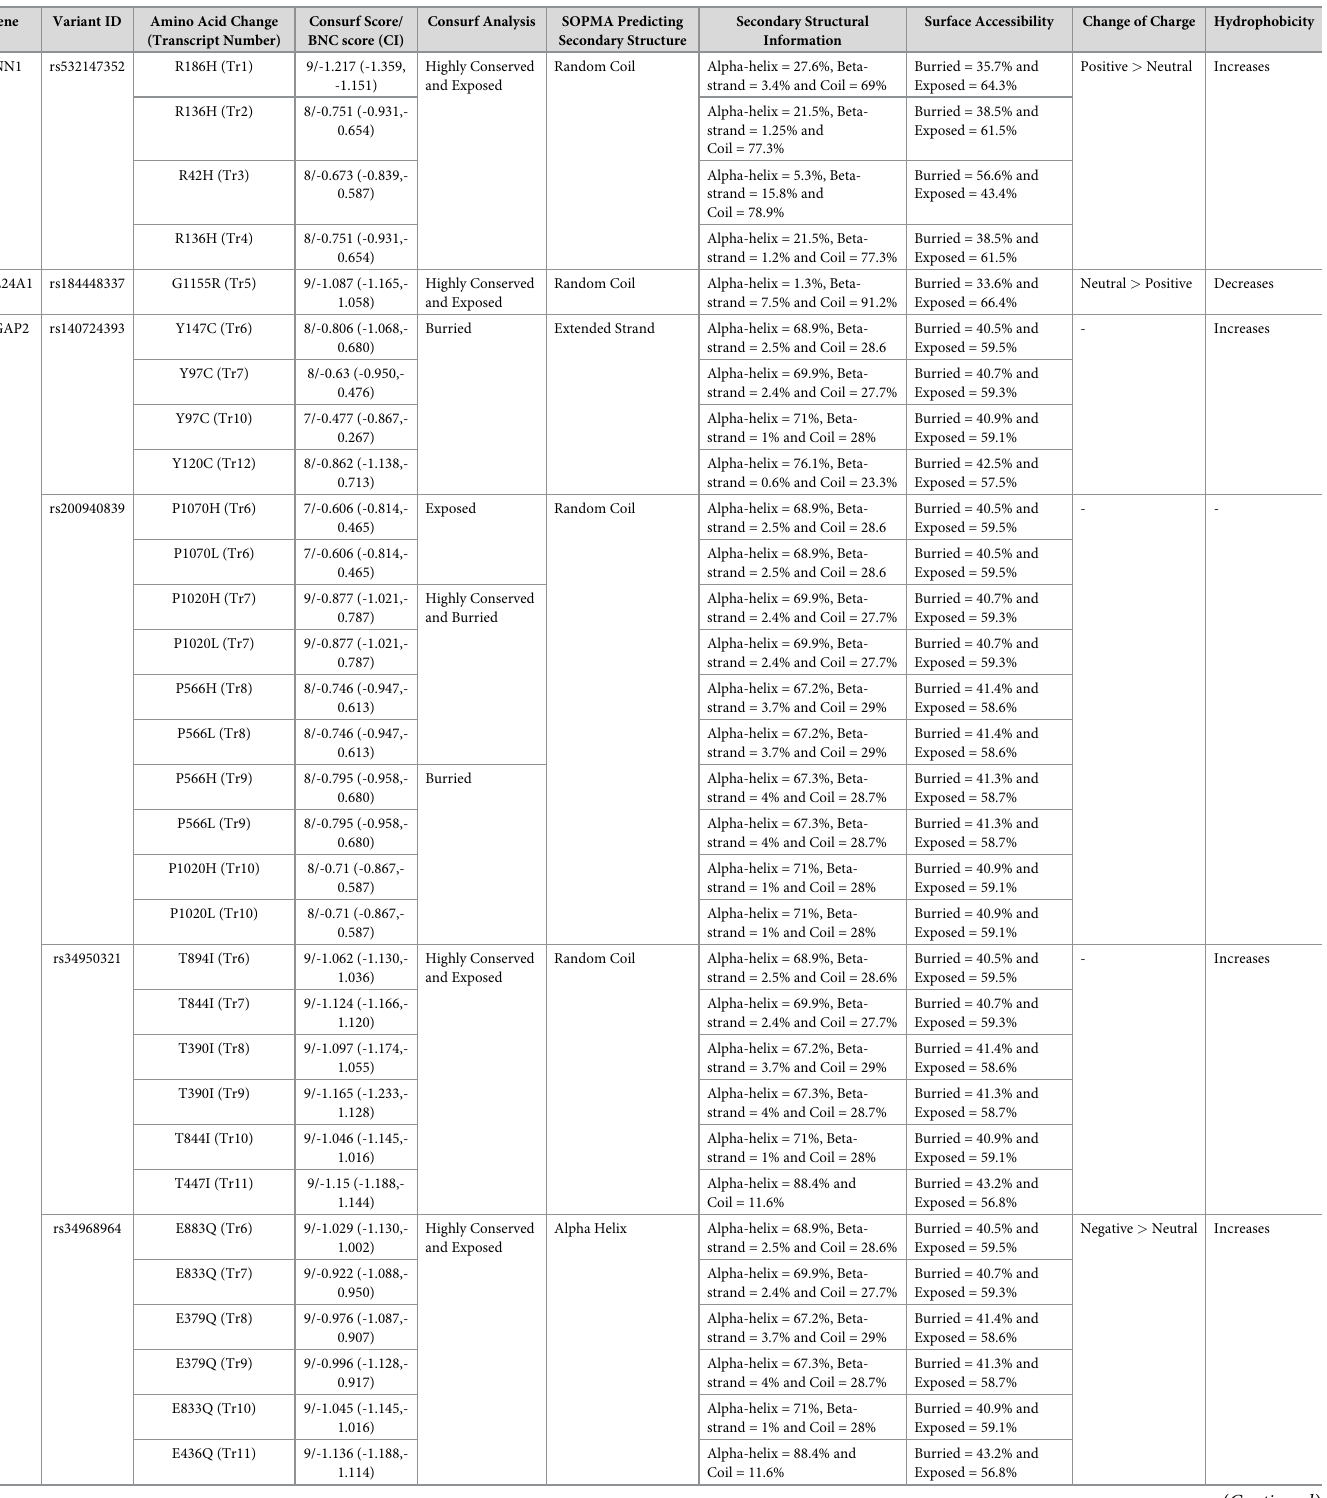
Table 5. Evolutionary conservation analyses and protein structure prediction of rare nsSNPs of PTB-related genes. Gene